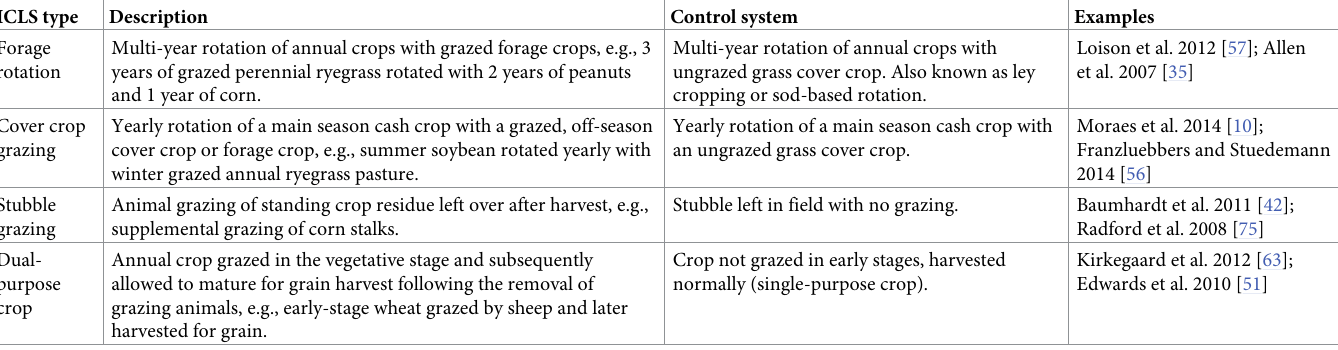
Annual crop grazed in the vegetative stage and subsequently allowed to mature for grain harvest following the removal of grazing animals, e.g., early-stage wheat grazed by sheep and later harvested for